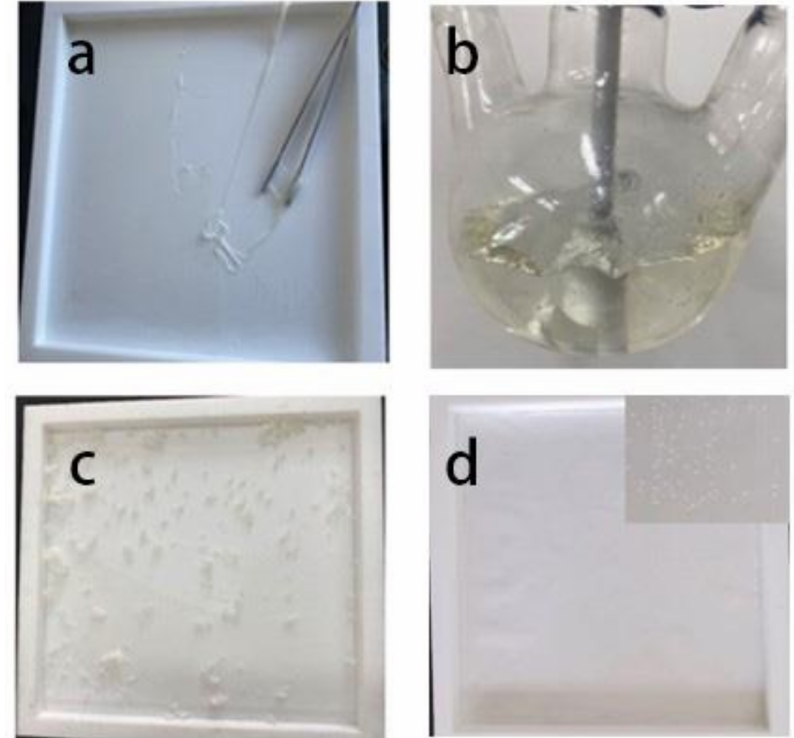
Figure 2. ( a ) When the R value is too small, the BPU cannot form a film. ( b ) When the R value is too large, the BPU in the gel state. ( c ) When the film forming temperature is low, the BPU in the wax form. ( d ) When the film forming temperature is too high, a large number of bubbles appear in